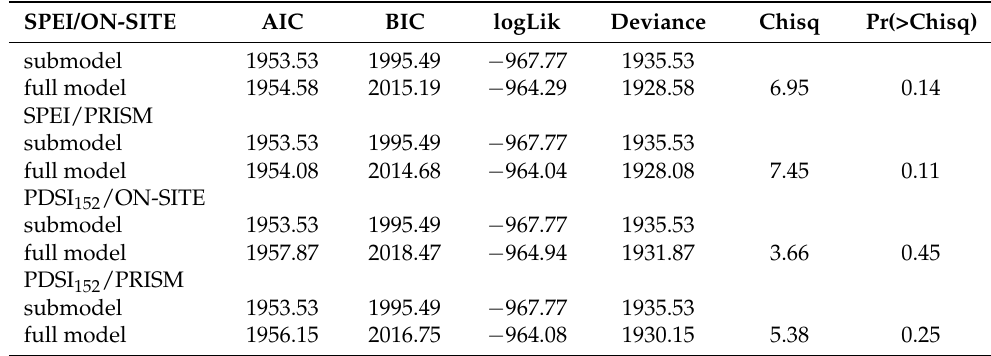
Table 5. Fitted models predicting BAI at HM using on-site or PRISM parameterizations of SPEI or PDSI152. The number of parameters for the submodel was nine; that for the full model was 13. The degrees of freedom numbered four in all